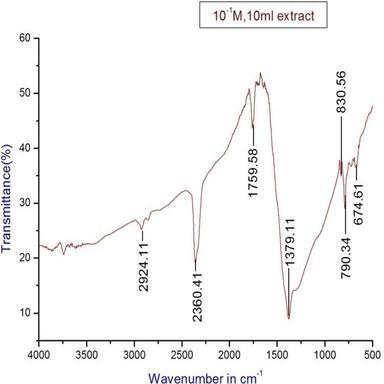
TIR spectra of Moringa Oleifere leaf Extract